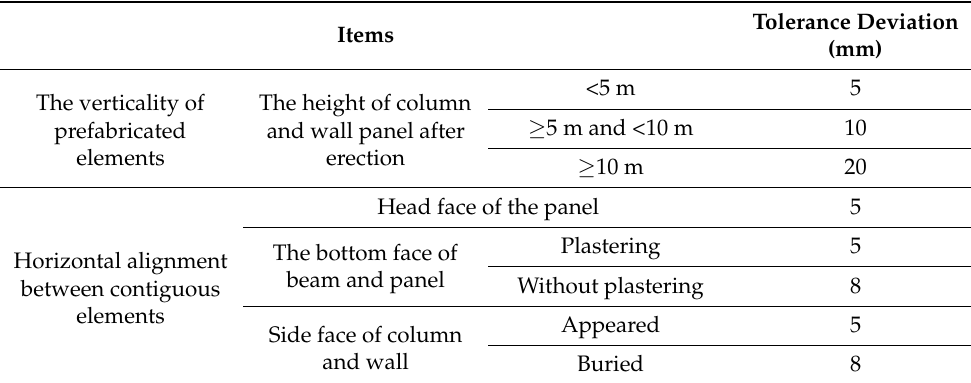
Table 1. Dimensional tolerance deviation of prefabricated structures in China